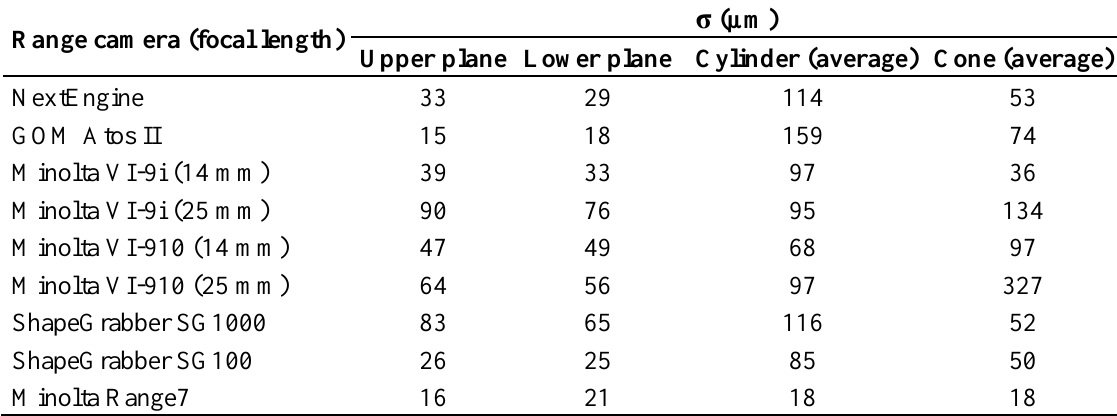
Table 4. Uncertainty related to the different geometries analyzed in the set of